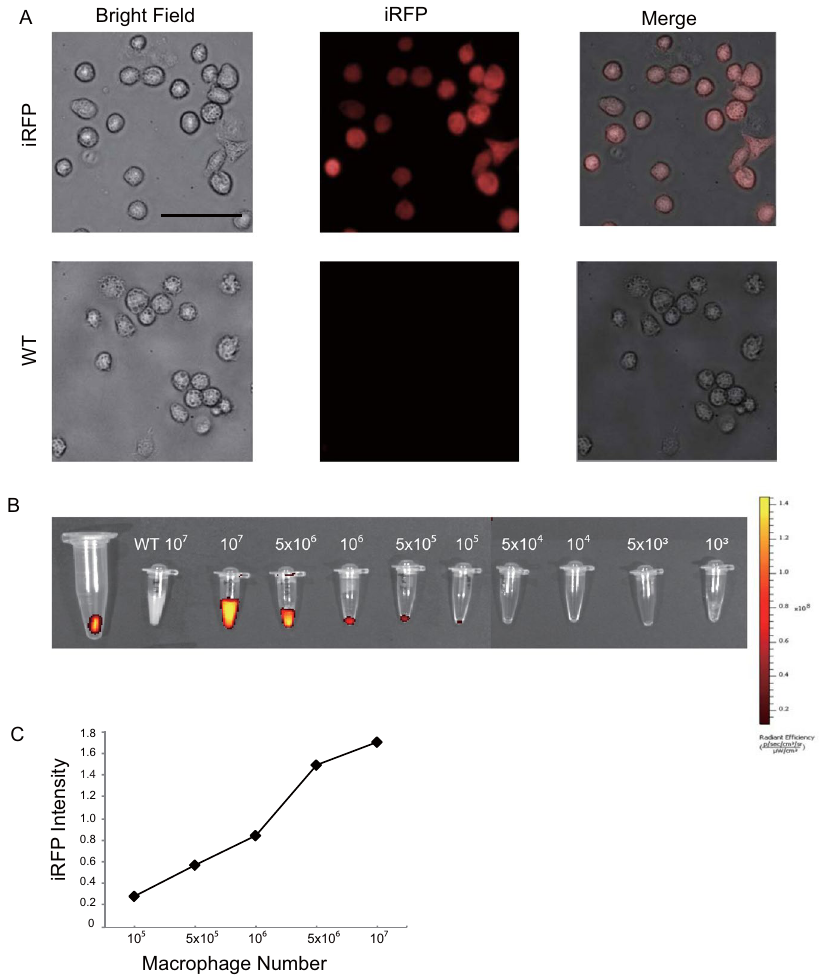
Figure 1. iRFP TG mouse macrophages express fluorescence in vitro . ( A ) Peritoneal macrophages from iRFP TG and WT mice observed by fluorescence microscope under a Cy5.5 filter. A clear, fluorescent signal was observed only in the iRFP TG macrophages (scale bar, 50 µ m). ( B ) The observed iRFP signal with an augmenting number of iRFP TG mouse peritoneal macrophages in comparison to 1 × 10 7 WT peritoneal macrophages by the IVIS spectrum under 710 nm and 760 nm excitation and emission wavelengths, respectively. The number of iRFP TG macrophage cells required to emit a detectable iRFP signal by the spectrum IVIS under the above conditions was determined to be 1 × 10 5 cells. ( C ) The observed iRFP signal intensity with the corresponding macrophage number. A gradual increase in iRFP signal was observed with increasing cell number. The signal intensity was measured by the Living Image